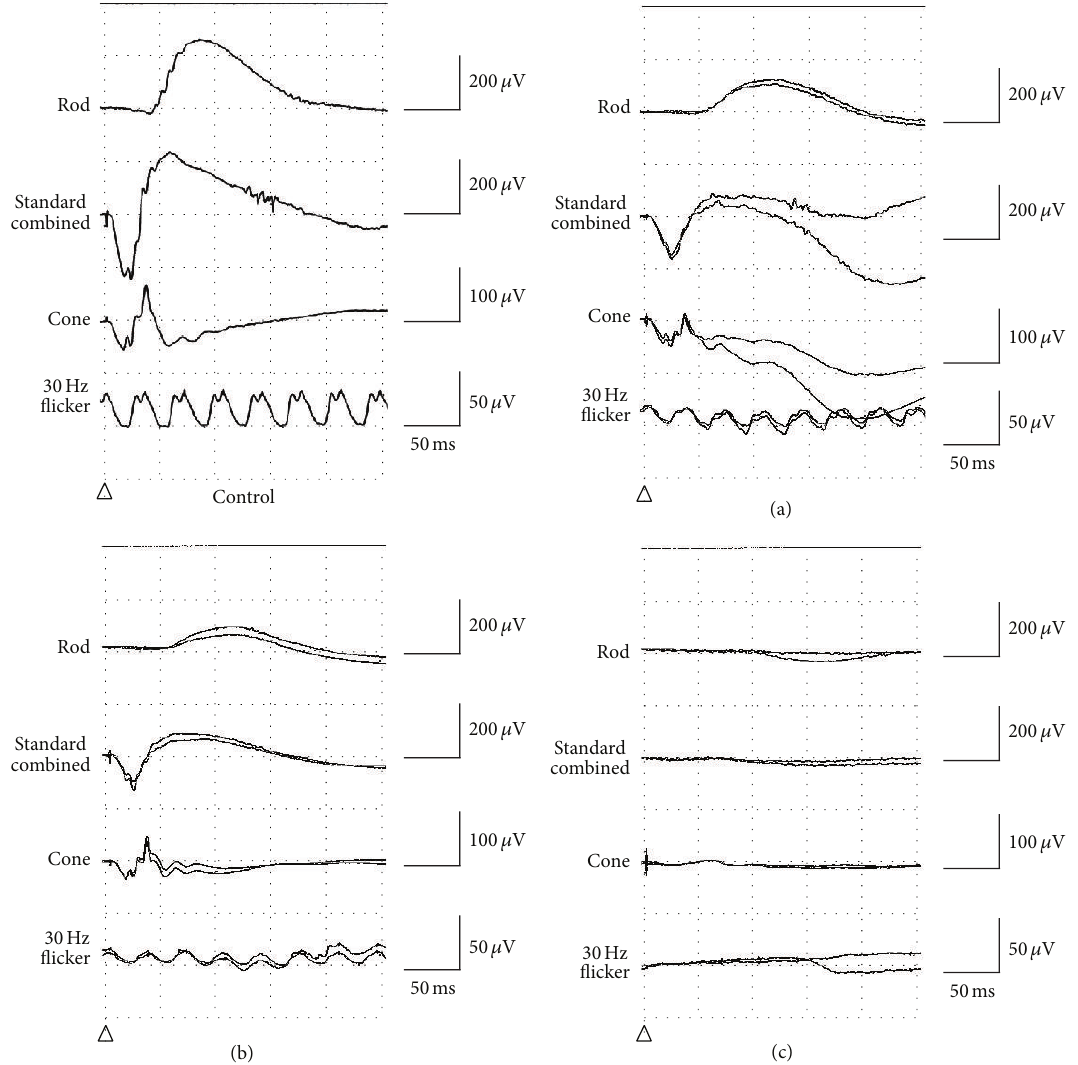
Figure 3: Full-field electroretinograms (ERGs). (a) and (b) ERG of both patient II-2 (a) and patient III-1 (b) in family 1 shows diminished amplitudes of the rod, standard combined, cone, and 30-Hz flicker responses. (c) ERG of patient II-1 in family 2 is nonrecordable for the rod, standard combined and 30-Hz flicker